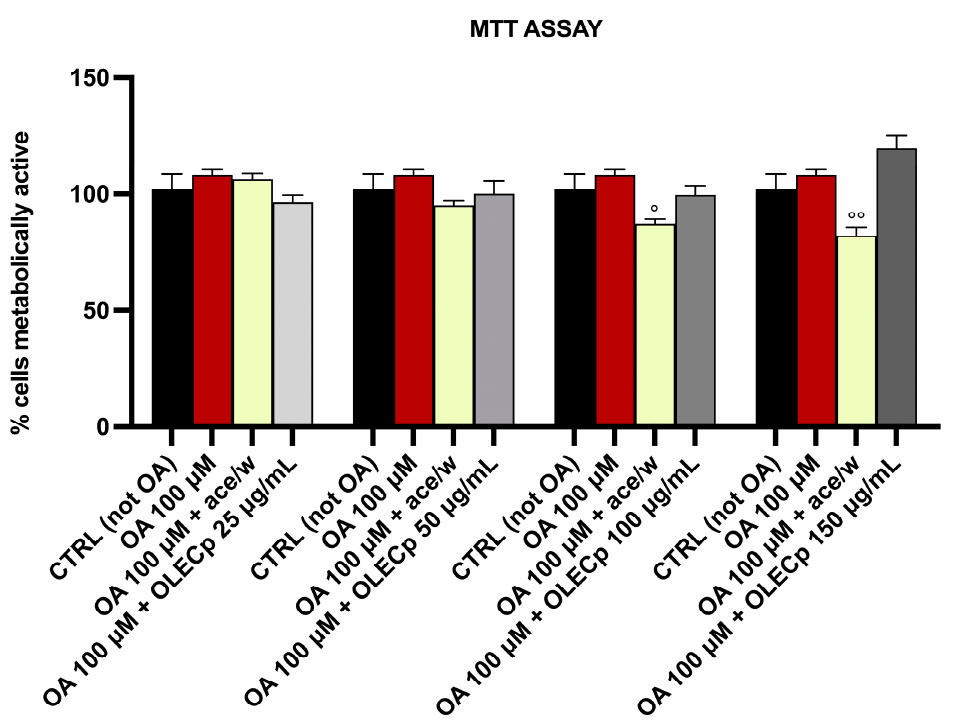
Figure 8. MTT Assay. Effect of 100 μ M of OA, vehicle (ace/w, 50/50, % v / v ) and different concen- trations of OLECp after 24 h on McA-RH7777 cells metabolic activity. The results are expressed as mean ± SEM of three independent experiments; °: p < 0.05, °°: p < 0.01 vs. OA 100 μ M.